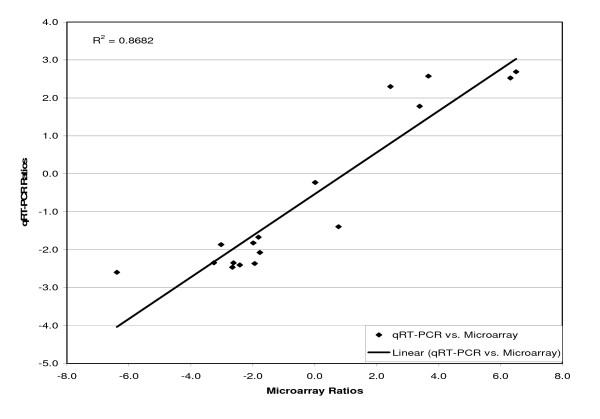
Correlation between the microarray and the qRT-PCR data of 17 randomly selected genes. The ratios of changes in gene expression, from the microarray (each S. Typhimurium ORF was spotted in triplicate on the slide) and qRT-PCR experiments, for the arcA mutant relative to the WT were log2 transformed and linearly correlated. The genes selected and the primers used in qRT-PCR are listed in Table 2. Three amplifications of each of the 17 genes were made using 1:5:25 dilutions of the total RNA.